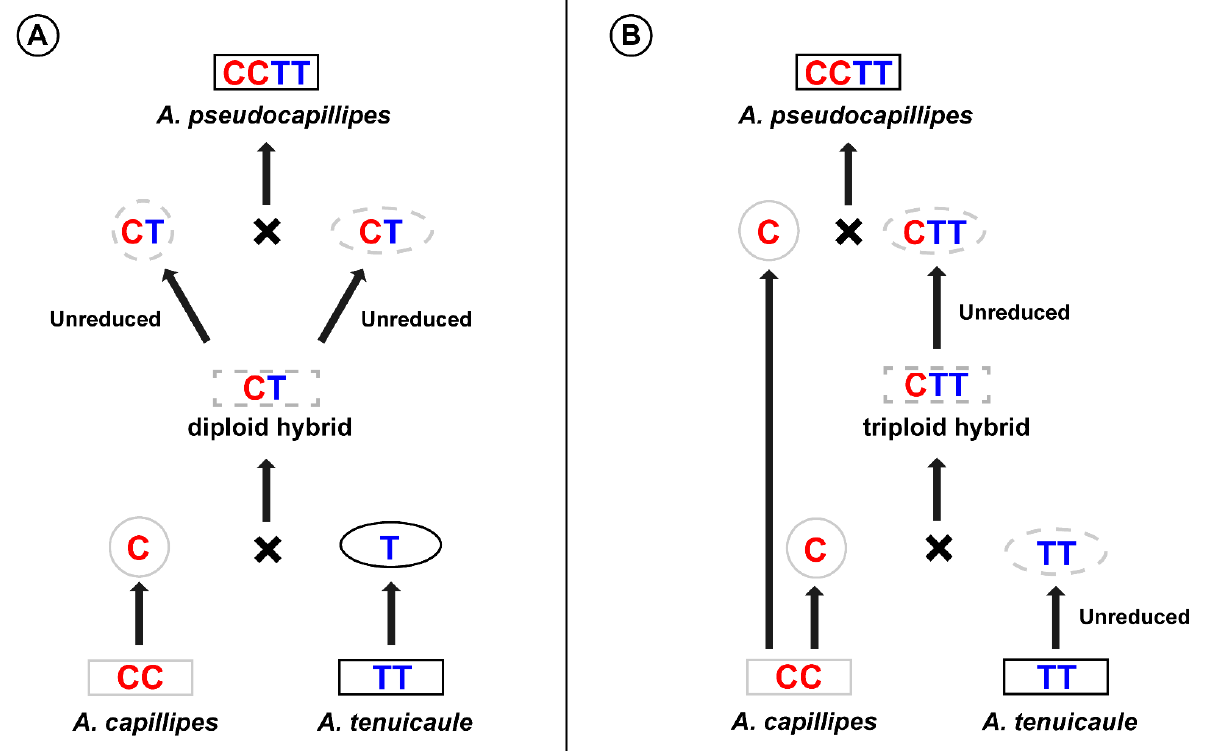
Figure 5. Two scenarios for the origin of A. pseudocapillipes . ( A ) Direct allopolyploidization via diploid hybrid. ( B ) Allotetraploidization via triploid bridge. Boxes represent each taxon and circles indicate gametes. Solid and dashed lines indicate known and putative taxa or gametes, respectively. The colors of the lines indicate whether it is native to Korea: black, native; gray, not native or unreported.